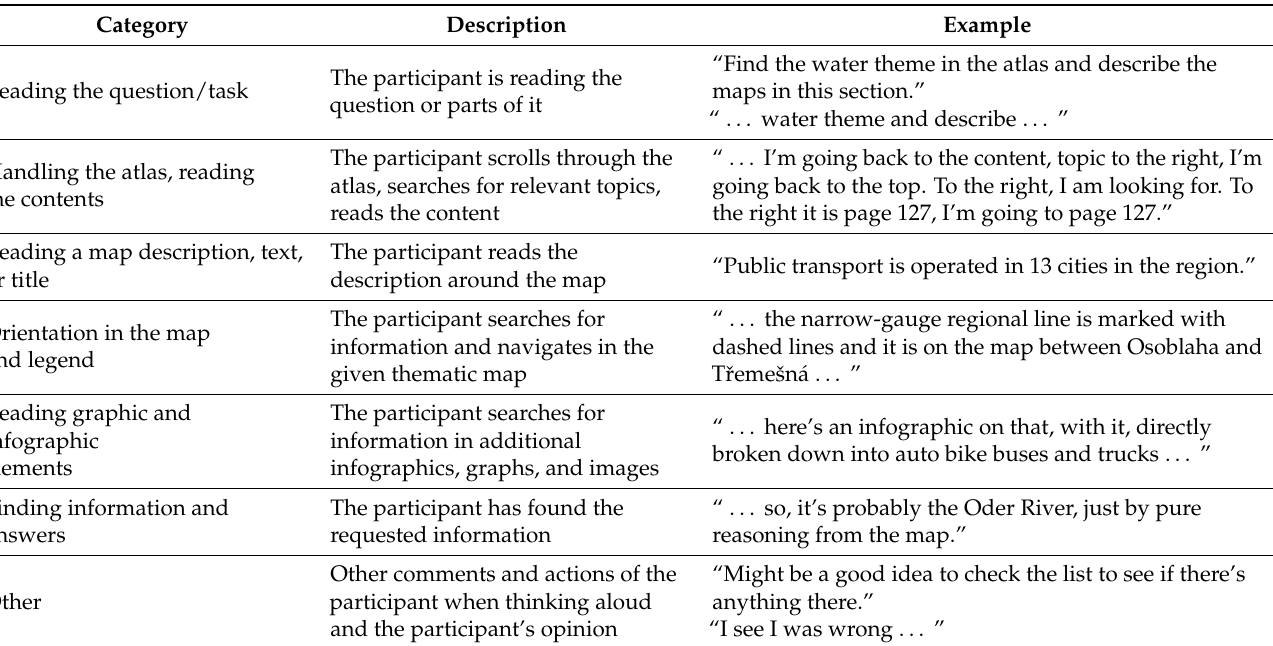
Table 2. The coding scheme used for audio processing